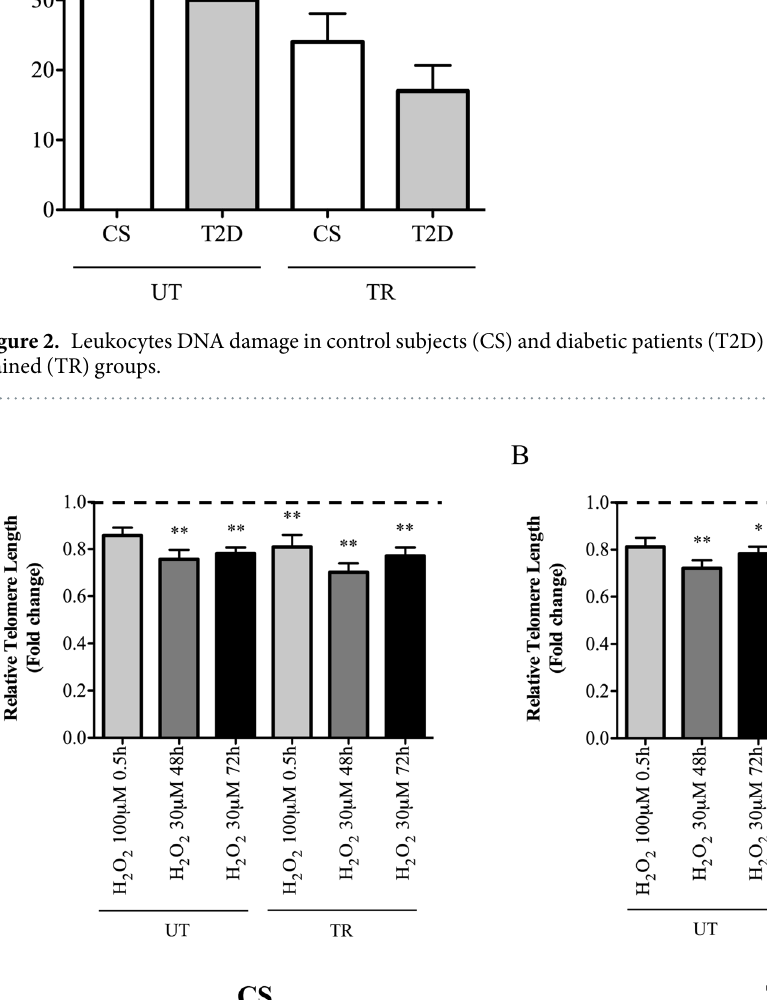
a trend toward a decrease in spontaneous DNA damage as compared to untrained subjects (P > 0.05). Effect of training on H O -induced telomere shortening and DNA damage in leukocytes from 2 2 control and diabetic subjects. The Two-Way ANOVA indicated that an ex vivo treatment of leukocytes with H 2 O 2 induced a similar effect on telomere length in both CS and T2D patients, (Fig. 3A and B). In com- parison with untreated cells, all chronic treatments with H 2 O 2 30 μ M (48 and 72 h) induced a significant LTL (Kb) decrease of between 24% and 35% in both control and diabetic subjects (UT-CS: Untreated, 6.29 ± 0.57